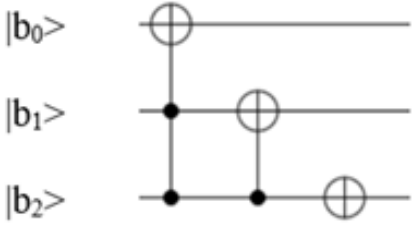
Figure 2. Representation of a quantum vector and quantum operations.